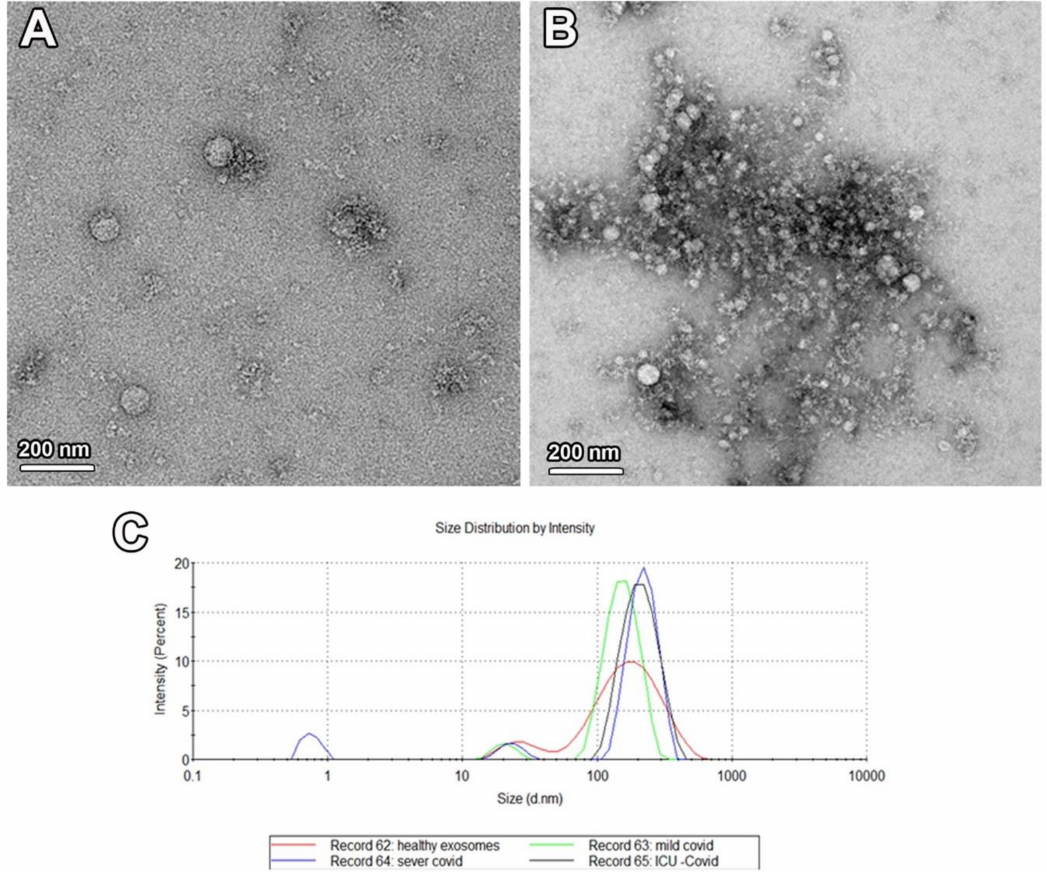
Figure 1. Characterization of isolated exosomes from control and patient samples. TEM examination shows MVs in serum samples isolated from the healthy controls ( A ) and COVID-19 patients ( B ). ( C ) NanoSight graph shows average size of the isolated exosomes.